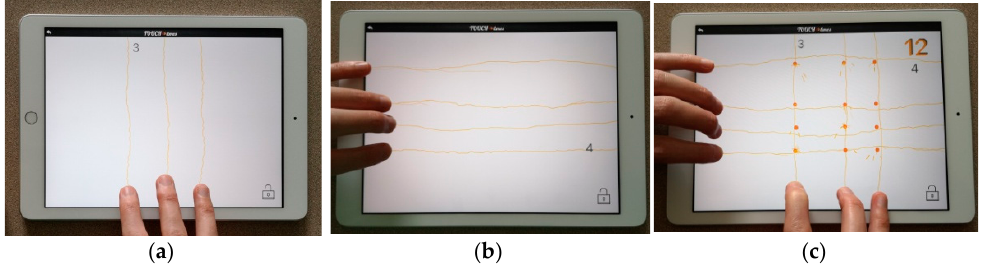
Figure 6. ( a ) Vertical lines, ( b ) horizontal lines ( c ) both horizontal and vertical lines.